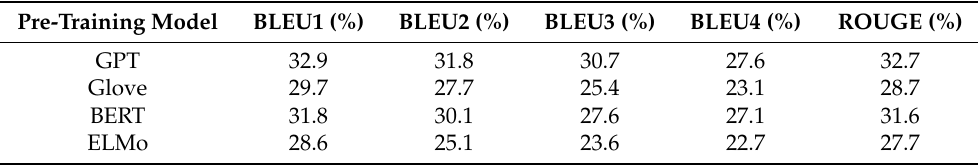
Table 4. Effects of seq2seq LSTM Q&A model under different pre-training